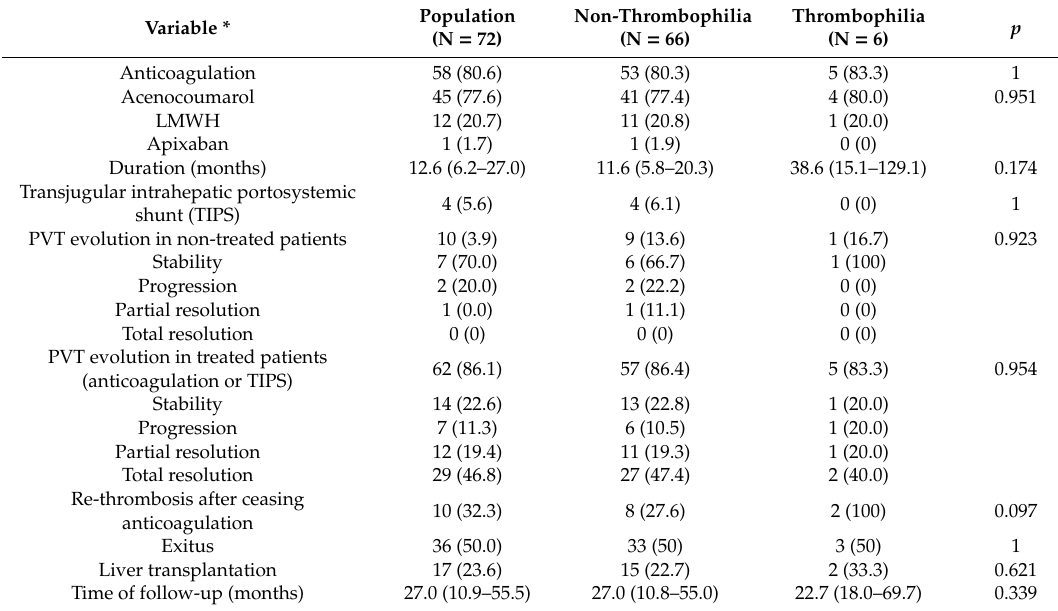
Table 4. Treatment and outcome of portal vein thrombosis in the whole cohort and in patients with and without